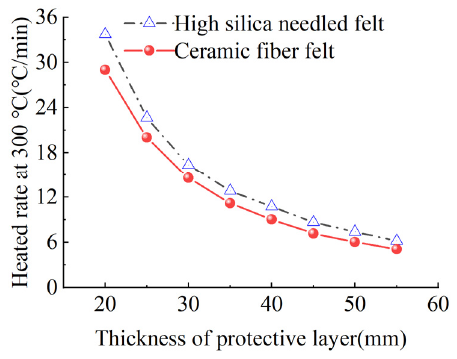
Figure 22. Heating rate at 300